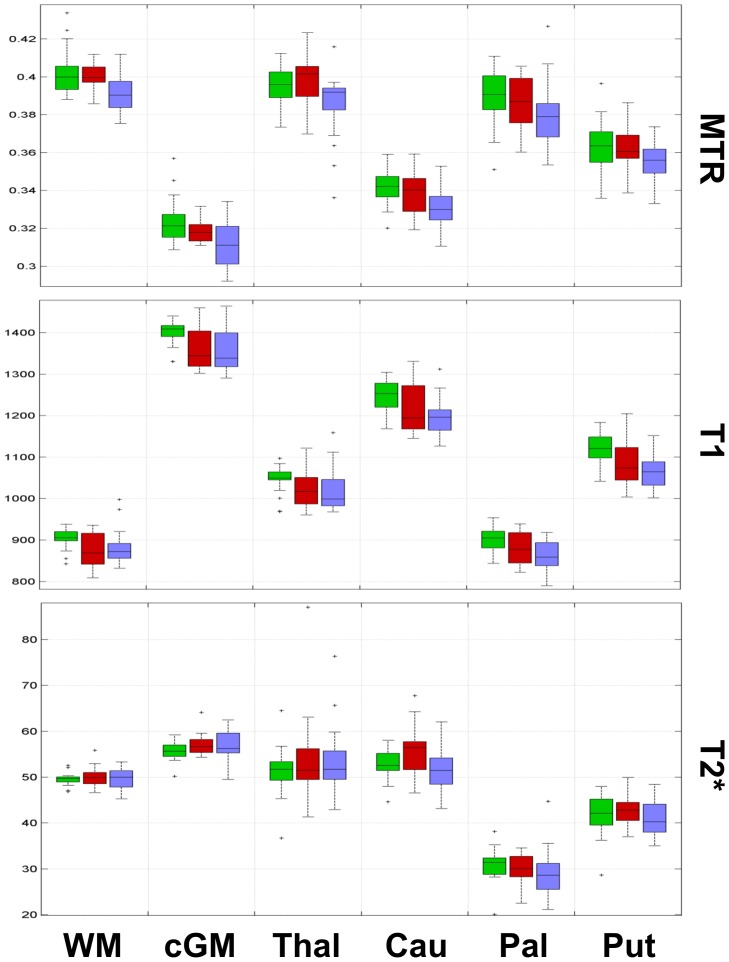
Boxplots representing data from the univariate analysis for WM, cGM, thalamus and basal ganglia.In each box, the central mark represents the median, the edges represent the 25th and 75th percentiles and the whiskers extend to the most extreme data points not considered outliers; outliers are plotted individually as x. HC: green; MND−: red; MND+: blue.